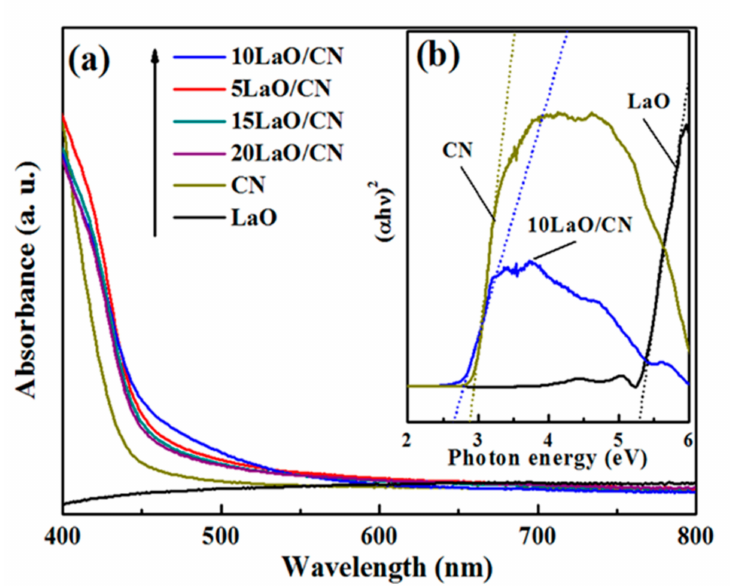
Figure 5. The UV–visible diffuse reflection patterns of LaO, CN, 5LaO/CN, 10LaO/CN, 15LaO/CN and 20LaO/CN ( a ); inset: plots of the (ah ν ) 2 vs. photon energy (h ν ) for LaO, CN and 10LaO/CN ( b ).